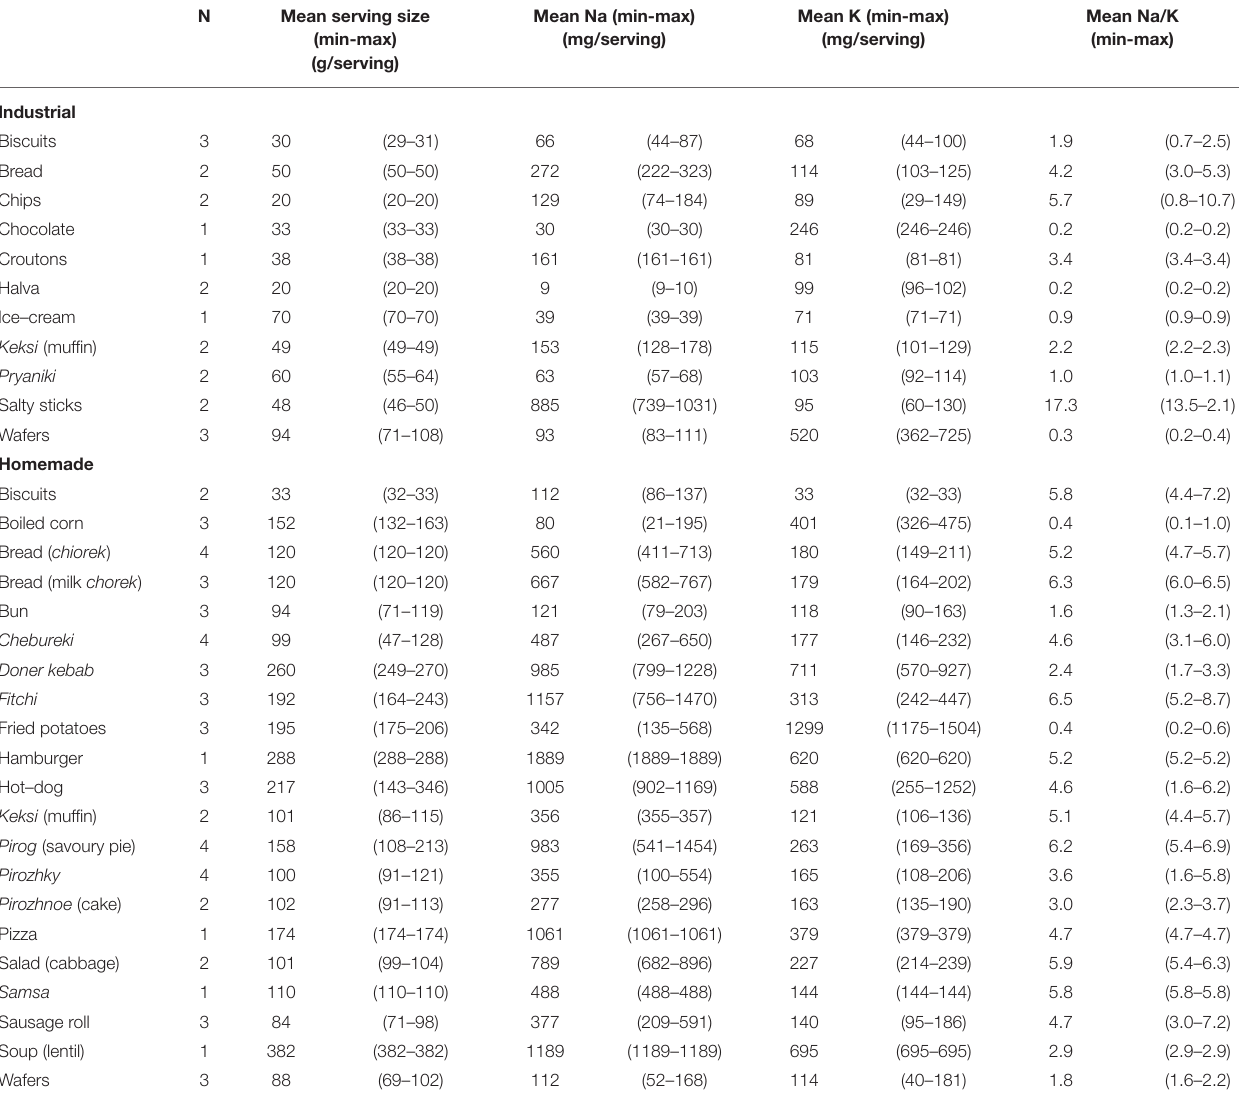
TABLE 3 | Nutritional composition (Na, K and Na/K), per serving, of the street food samples collected in